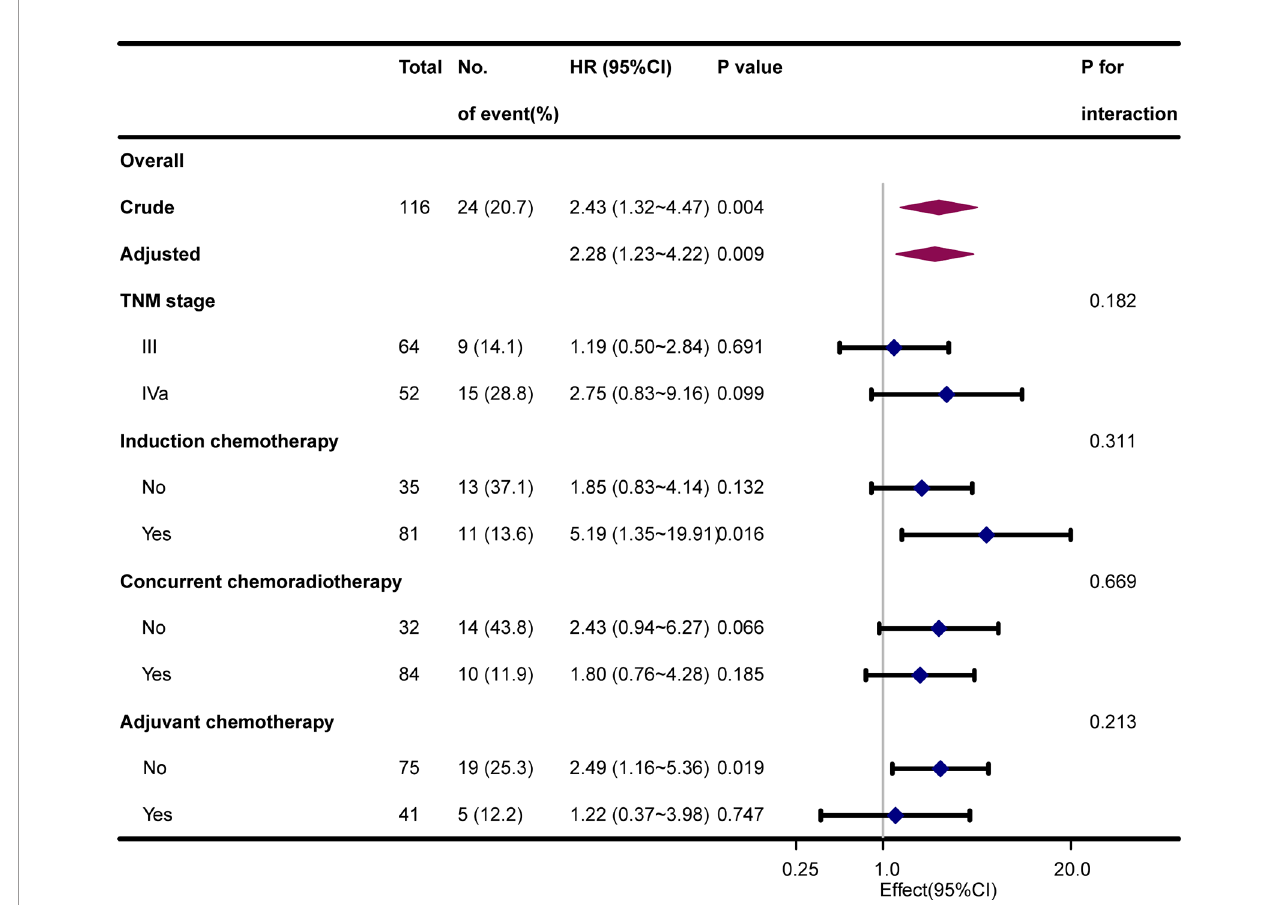
FIGURE 3 | Hazard risk of bone metastasis in subgroup analyses after adjustment for hospital, age, sex, Karnofsky performance status, smoking index, and histological